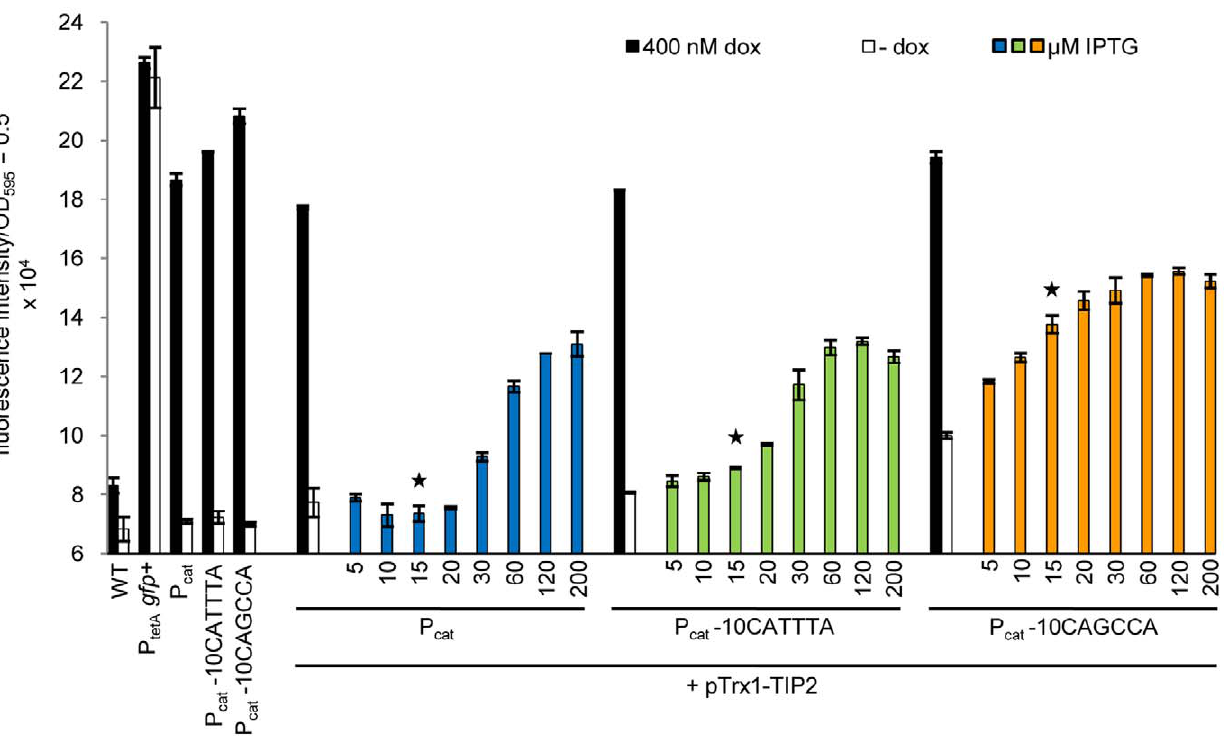
Figure 6. Dose-response curve of TetR induction by a plasmid-borne Trx1-TIP2 fusion protein in the strains with promoters P cat , P cat -10CATTTA or P cat -10CAGCCA expressing TetR. The promoter variants were incubated without and with 400 nM dox for maximum induction of TetR or with increasing IPTG concentrations for plasmid-encoded Trx1-TIP2 (pTrx1-TIP2) expression. The Salmonella WT strain, the reporter strain lacking TetR (P tetA gfp + ) and the promoter mutants without the plasmid served as controls and were incubated without and with 400 nM dox. The star marks the IPTG concentration at which the level of Trx1-TIP2 corresponds roughly to the endogenous Trx1 level. The bars represent the fluorescence intensity which was normalized to a 1 ml culture with OD 595 =0.5. The data are a representative set from at least three independent measurements and display the mean 6 standard